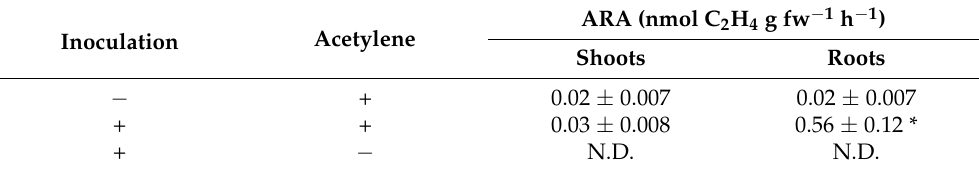
Table 6. Acetylene reduction activity of sweet potato cv. Beniazuma shoots and roots 5 months after Bradyrhizobium sp. AT1